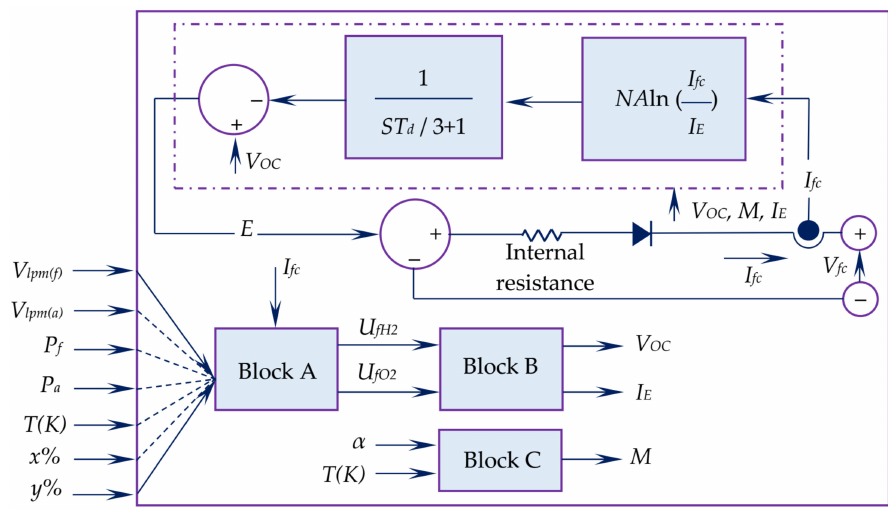
Figure 5. Detailed model of a PEMFC